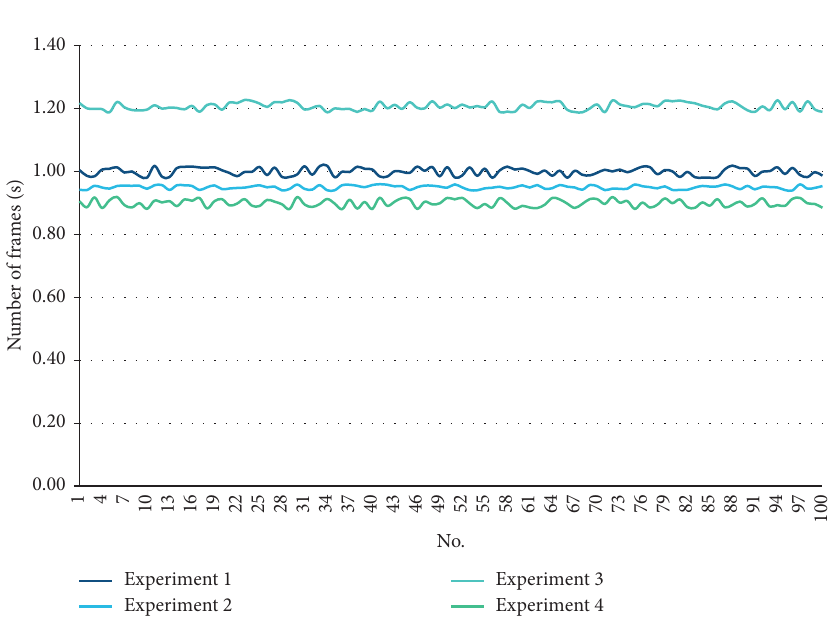
Figure 13: Statistical diagram of processing speed in the direct fusion mode